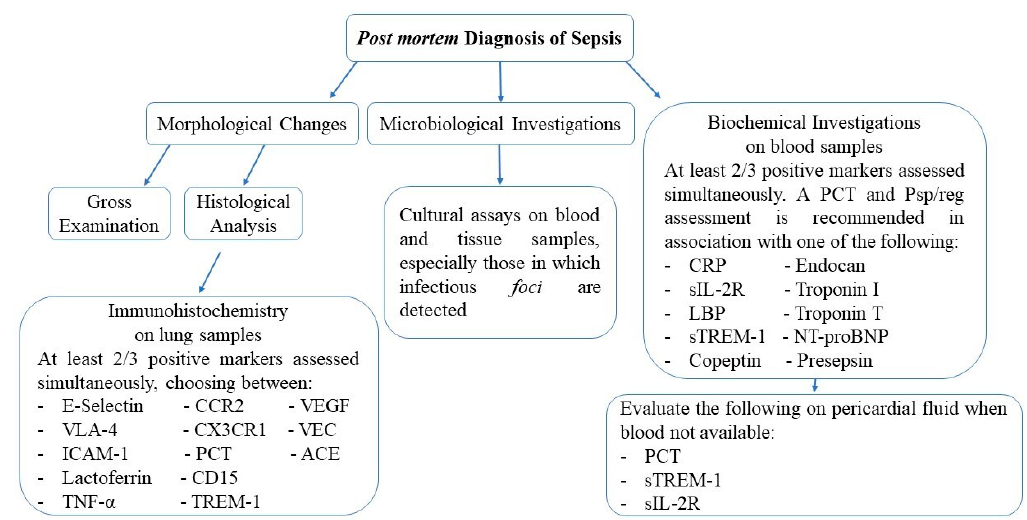
Figure 2. Schematic overview of the main investigations needed for a post-mortem sepsis diagnosis, with indications for a possible, effective, procedural combination.